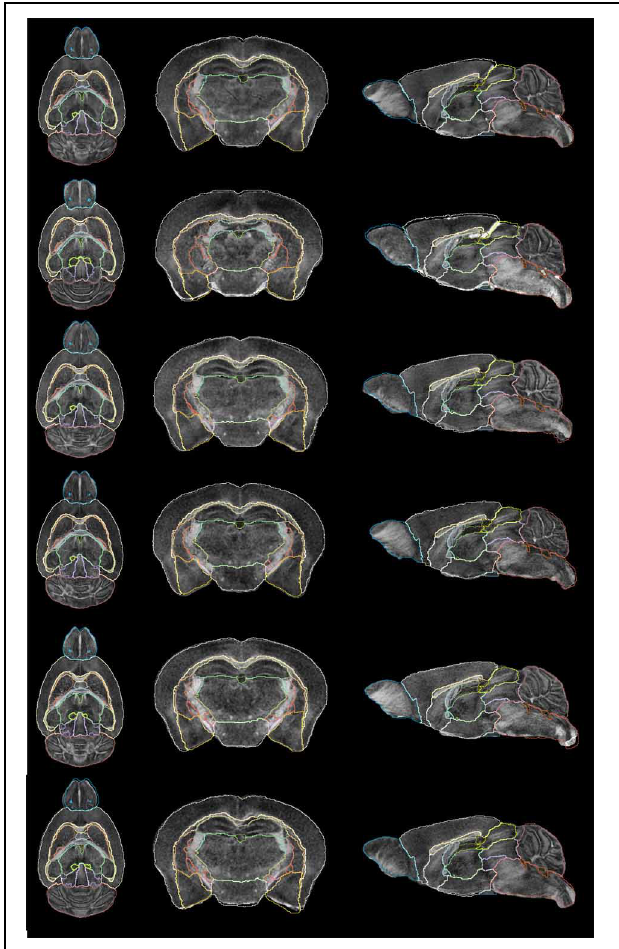
FIGURE 11 | Subject segmentation. From left to right: axial view, coronal view and sagittal view of cases 1–6